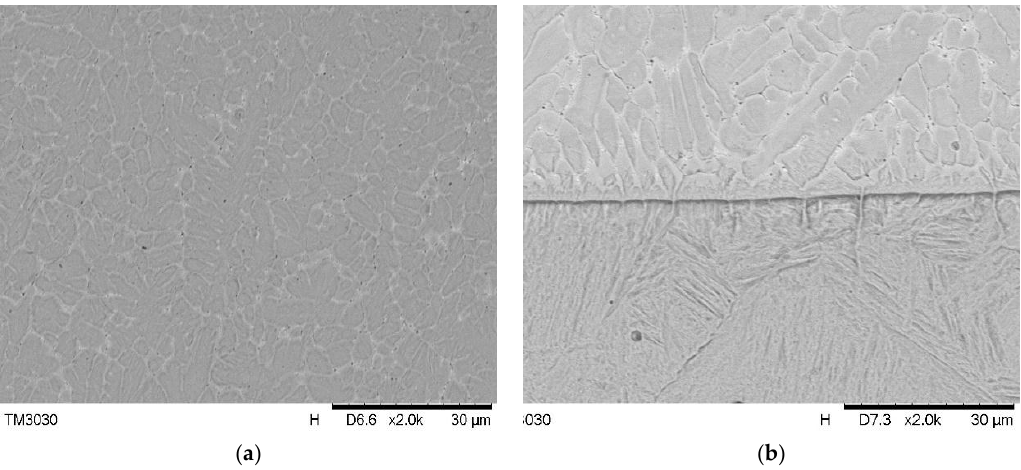
Figure 8 . ( a ) Cladding layer structure; ( b ) Interface between substrate and cladding layer.